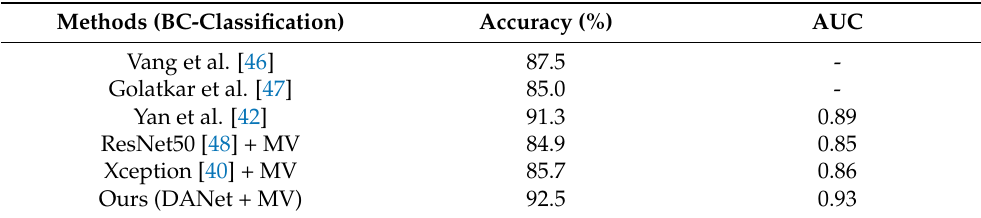
Table 1. Comparison with the previous methods on the BC classification